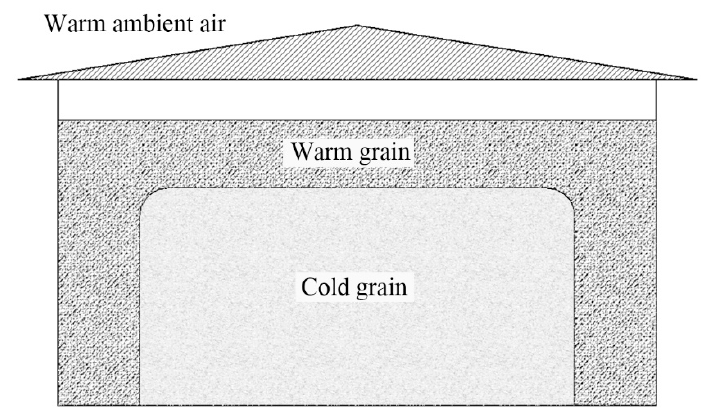
Figure 3. Schematic diagram of “cold core” in granary.